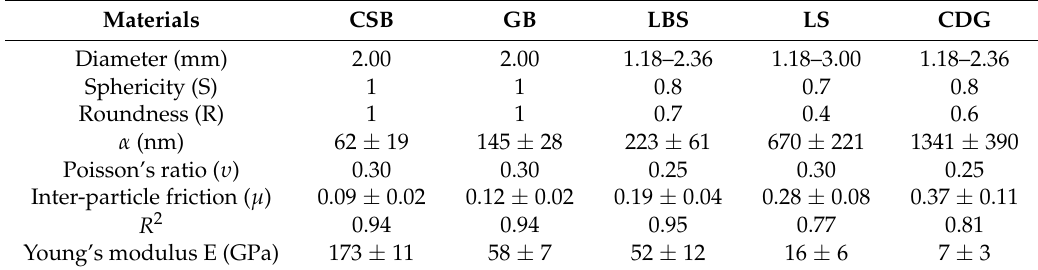
Table 1. Characterization of materials along with results from the inter-particle